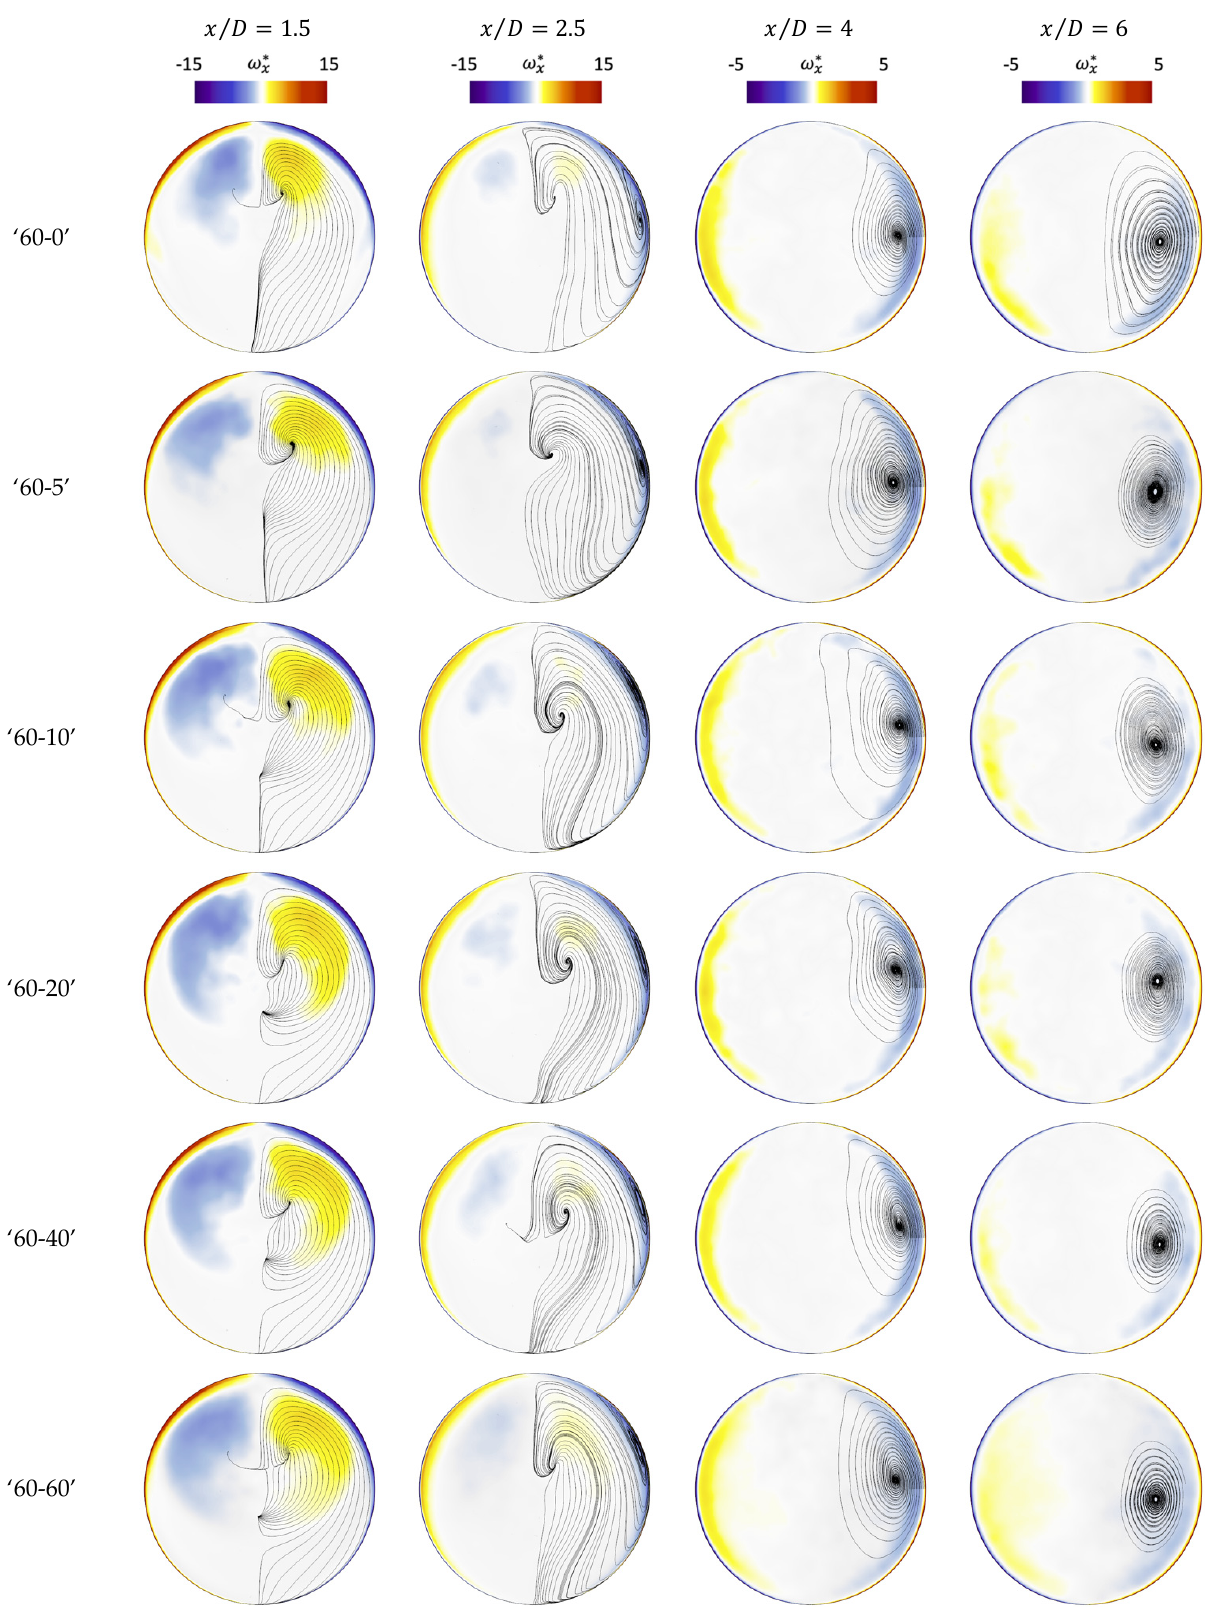
Figure 17. Contour plots of ω ∗ x with in-plane mean velocity streamlines (black lines) on different cross-sections for cases with fully developed BCs—Reattachment region.